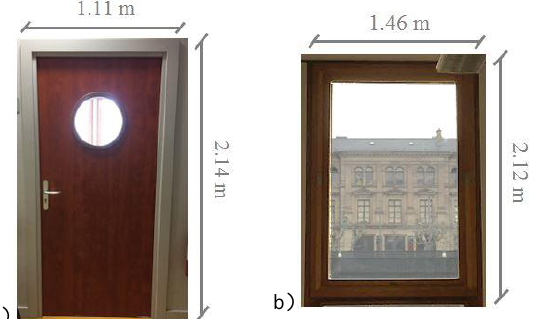
Figure 2. Pictures of door (a) and window (b) to